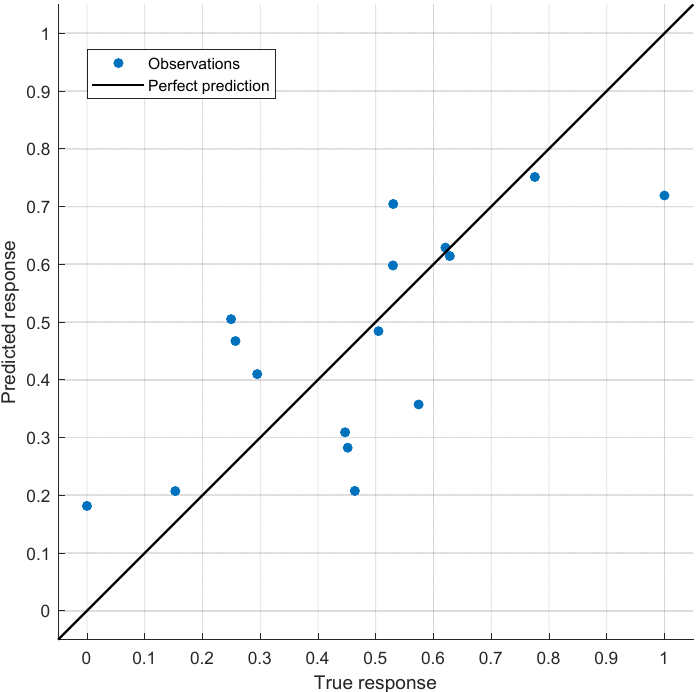
Figure 6. The predicted TVRR vs. the actual TVRR.